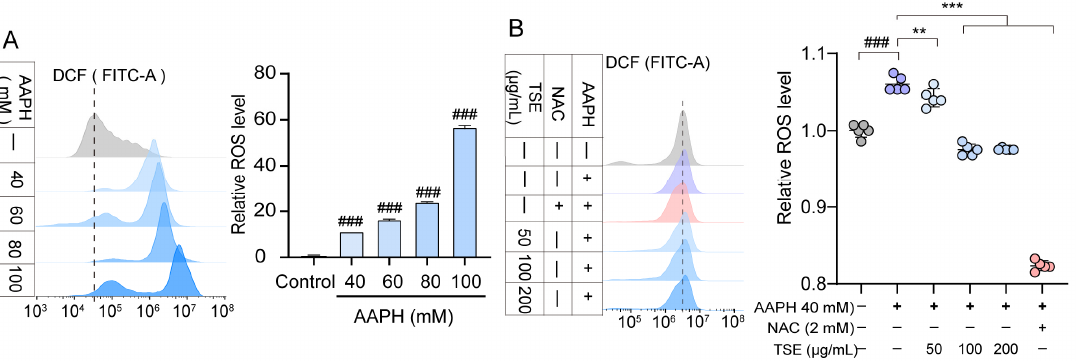
Figure 4. Effects of TSE on oxidative stress in AAPH-treated ATDC5 cells. ( A ) Oxidative stress in ATDC5 cells treated with AAPH (40–100 mM). n = 5; ( B ) ROS in AAPH-treated cells treated with the TSE (50–200 μ g/mL). NAC (2 mM) acts as a positive control. n = 5. Data were expressed as mean comparisons test (IBM SPSS Statistics 25.0, Armonk, NY, USA). ### p < 0.001 vs. the control group. **